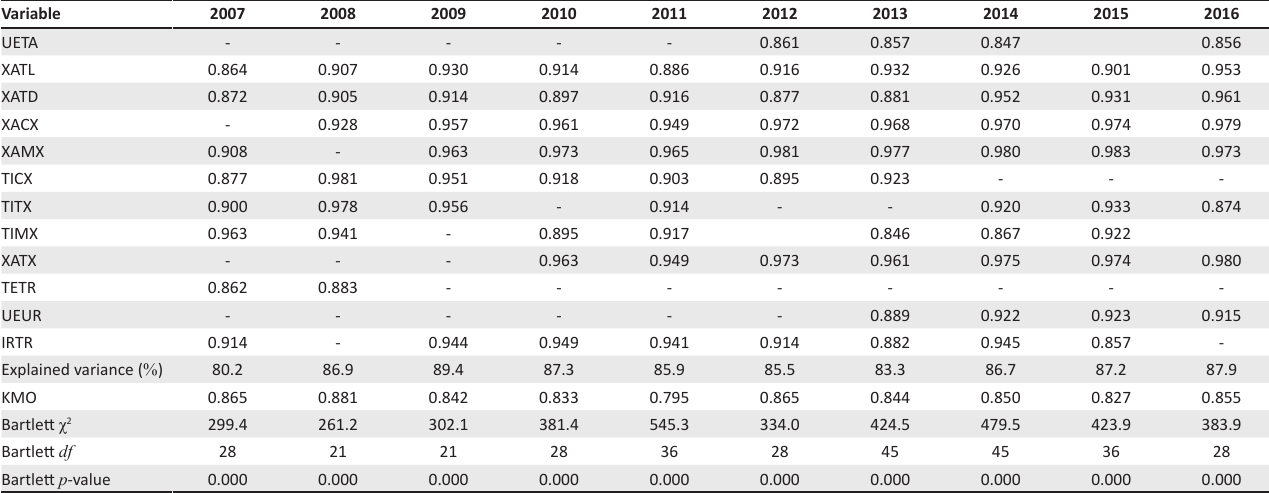
TABLE 6: Results of principal component analyses, 2007–2016.